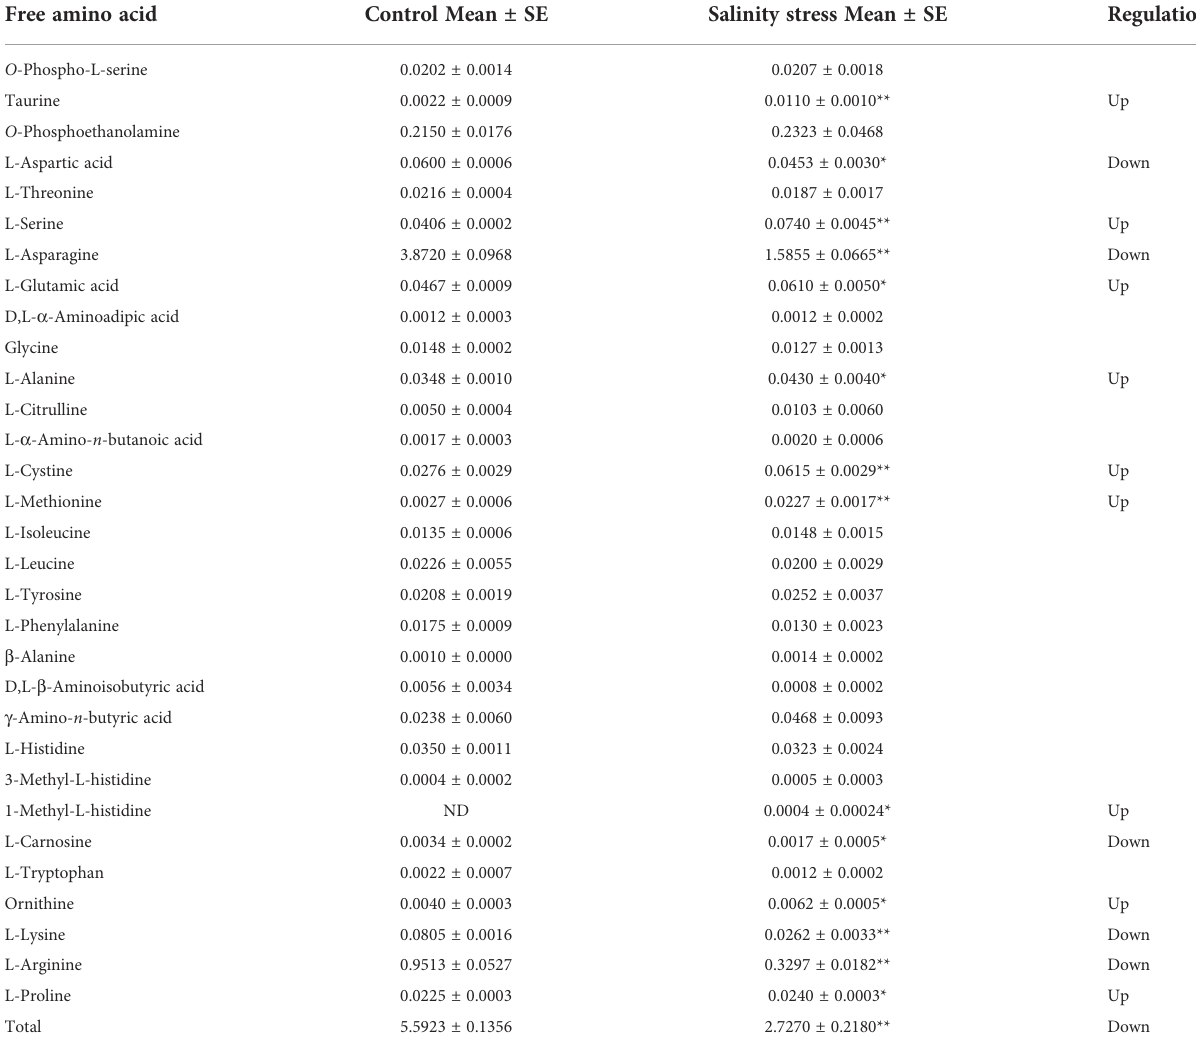
TABLE 1 Content of free amino acids (mg/100 mg DW) in Dendrobium of fi cinale roots in control and salinity stress